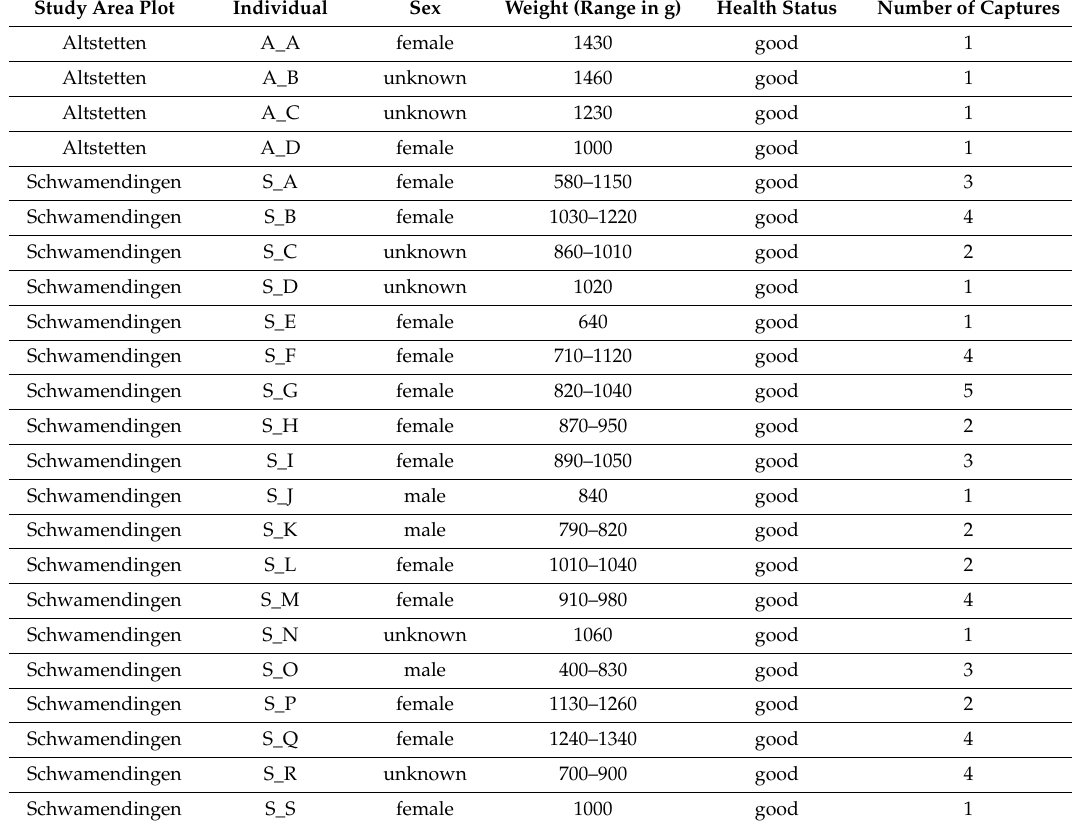
Figure A3. Estimation of the decrease in median distribution area (in percent (± 95% confidence interval), revealed through subsampling. With increasing size of the subsample, the estimate becomes more accurate, on the other side the degrees of freedom become more restricted (because overall sample size = 987 for 1992 and 1096 for 2016–2018). Our estimate resulted by averaging the values for subsample sizes 500 through 900. Table A1. Data sheet of all hedgehog captured during the 2017 capture-mark-recapture (CMR) study. Study Area